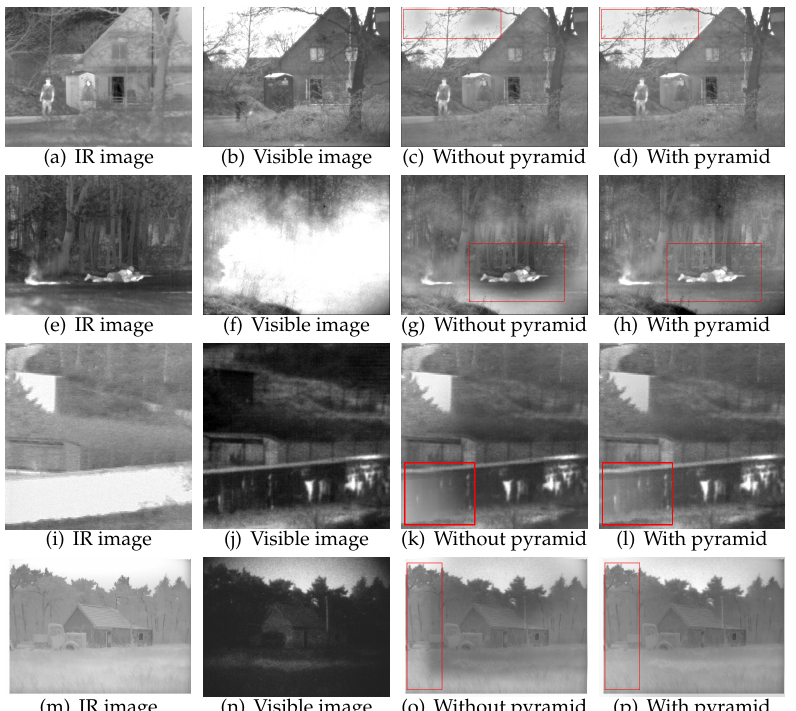
Figure 5. The ablation study of the image pyramid. The first column has IR images, the second column has visible images, the third column has images without the use of the image pyramid, and the fourth column has images with the use of the image